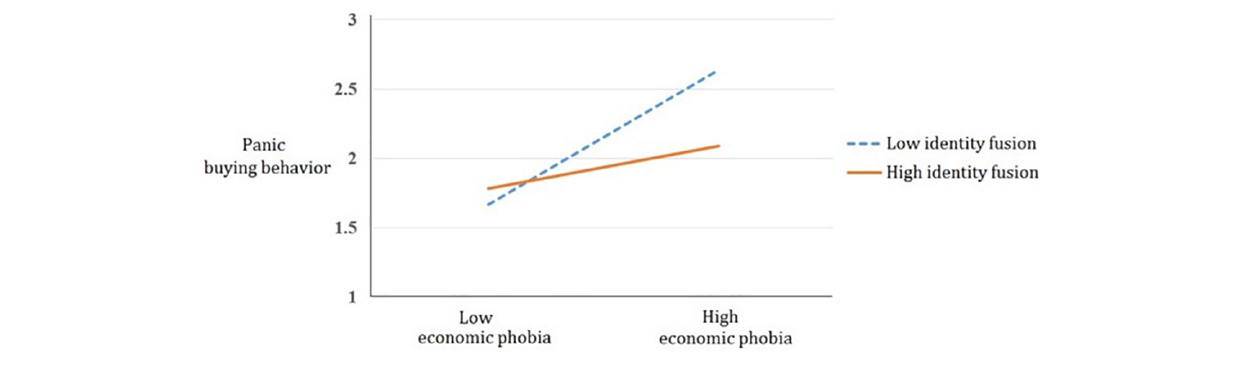
FIGURE 1 | The two-way interaction effect of the economic factor in COVID-19 phobia and identity fusion on panic buying behavior in the Taiwanese